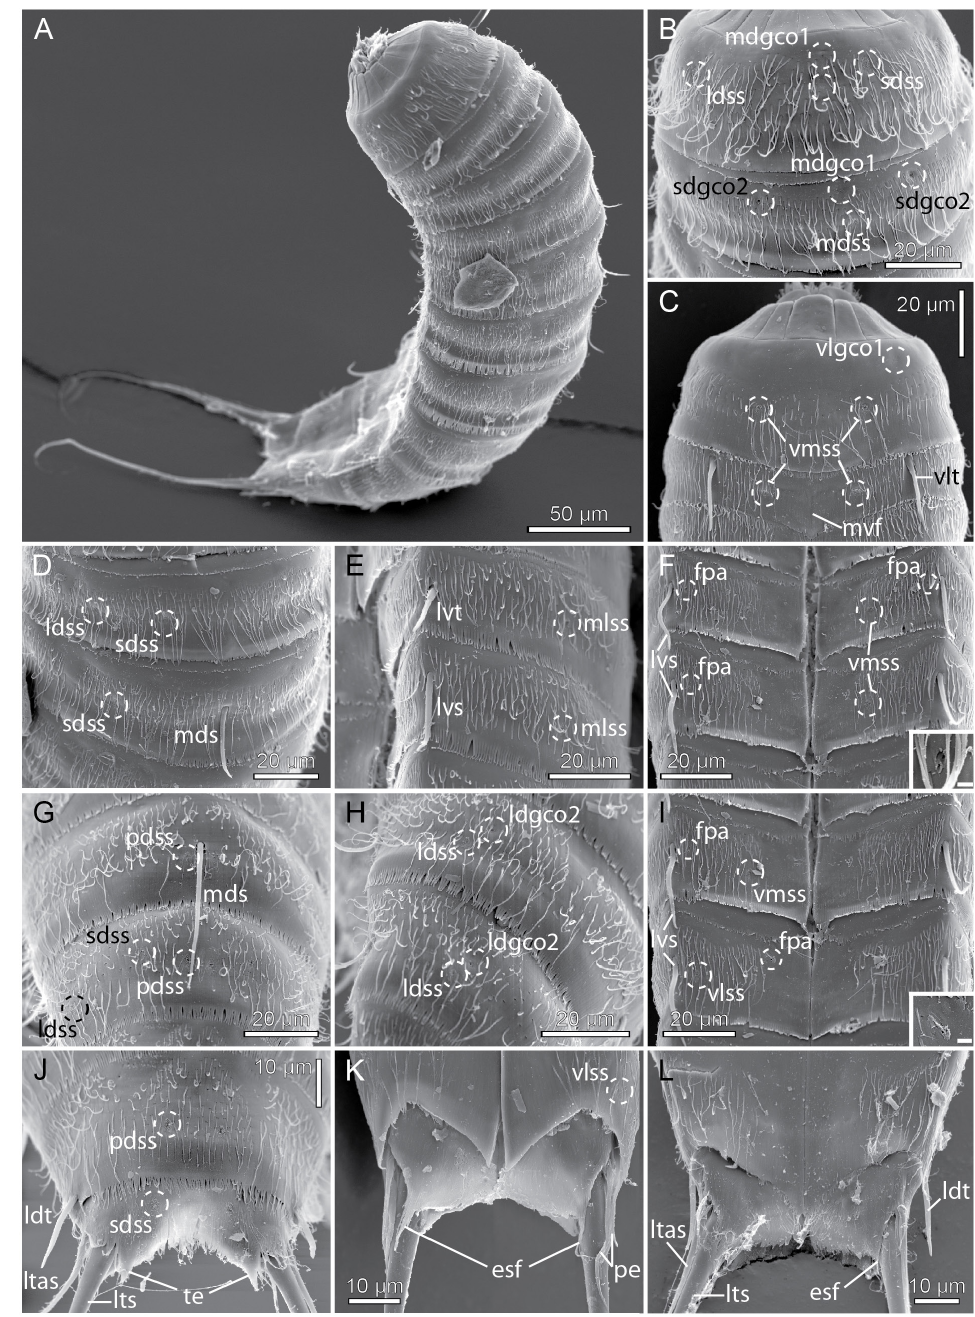
Fig. 10. Scanning electron micrographs showing overviews and details of Echinoderes pilosus Lang, 1949. A–J, L . ♀ (SMNH-9262, SMNH-9281). K .♂ (SMNH-9262). A . Lateral overview. B . Segments 1 to 2, dorsal view. C . Segments 1 to 2, ventral view. D . Segments 3 to 4, dorsal view. E . Segments 5 to 6, lateral view. F . Segments 6 to 7, ventral view, showing female sexual dimorphism; inset shows ventrolateral female papilla on segment 6, scale on inset = 1 µm. G . Segments 8 to 9, dorsal view. H . Segments 8 to 9, laterodorsal view. I . Segments 7 to 8, ventral view, showing female sexual dimorphism; inset shows ventromedial female papilla on segment 8, scale on inset = 2 µm. J . Segments 10 to 11 dorsal view, showing female sexual dimorphism. K . Segments 10 to 11 ventral view, showing male sexual dimorphism. L . Segments 10 to 11 ventral view, showing female sexual